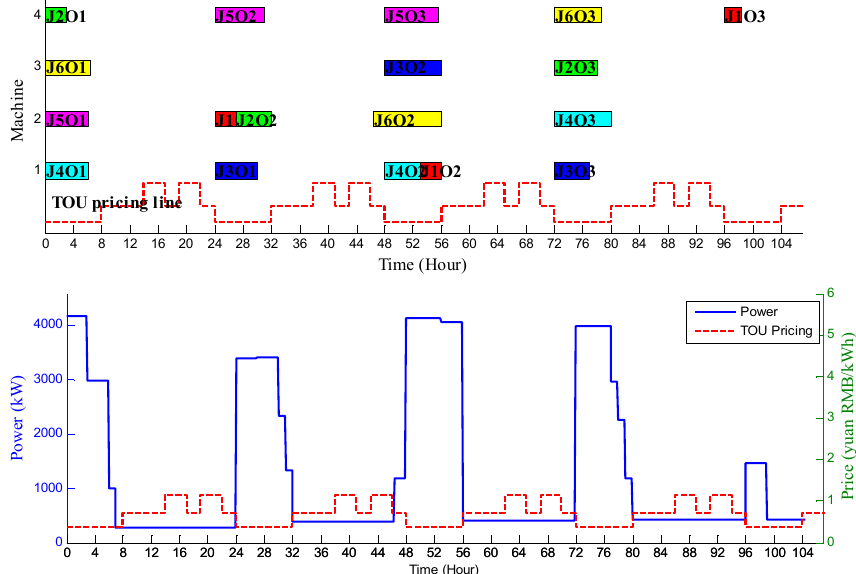
Figure 9. Gantt and power charts of the optimal solution to configuration C4 × 6&OPF.